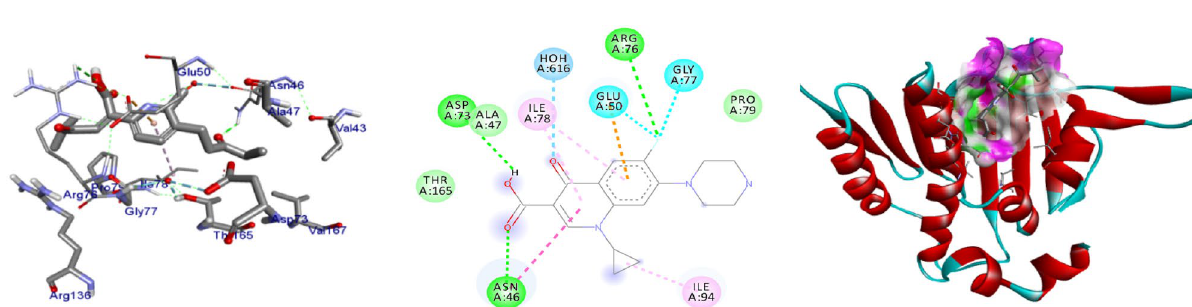
Figure 5. The 2D and 3D intermolecular contact between compound 5 and DNA gyrase B (PDB ID: 6F86). Chemical structures were drawn by ChemDraw Pro 16.0 Suite (PerkinElmer, USA) and analyzed by the Discovery studio visualizer (BIOVIA Discovery studio 2020 Client).